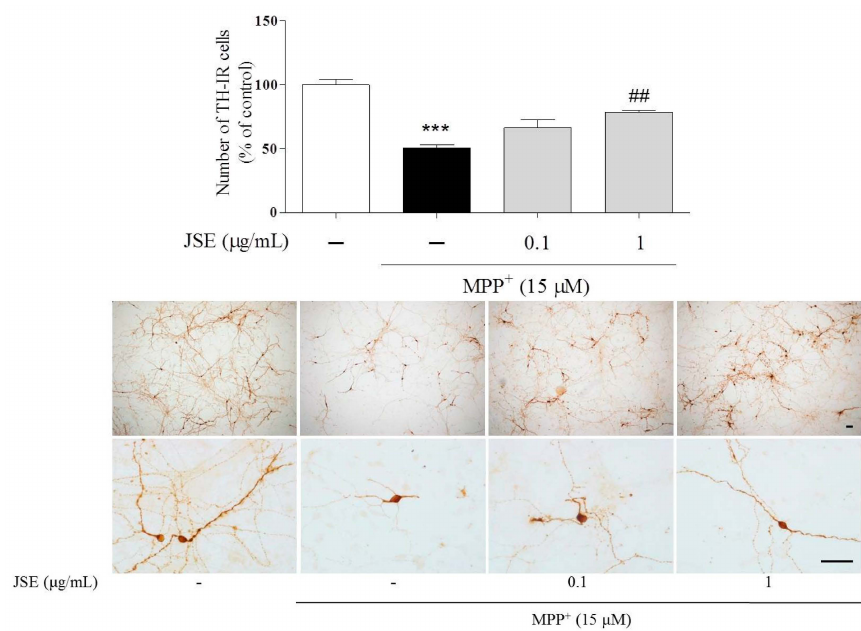
Figure 4. Effects of JSE against MPP + -induced neurotoxicity in vitro . Rat primary mesencephalic cells were treated with JSE for 1 h, followed by MPP + exposure for 23 h. The number of anti-tyrosine hydroxylase -immunoreactive (TH-IR) neurons was measured after cells were fixed and stained. Representative images are shown. Scale bar = 100 µ m. Values were expressed as means ˘ SEM. *** p < 0.001 vs. the control group; ## p < 0.01 vs. the MPP + -only treated